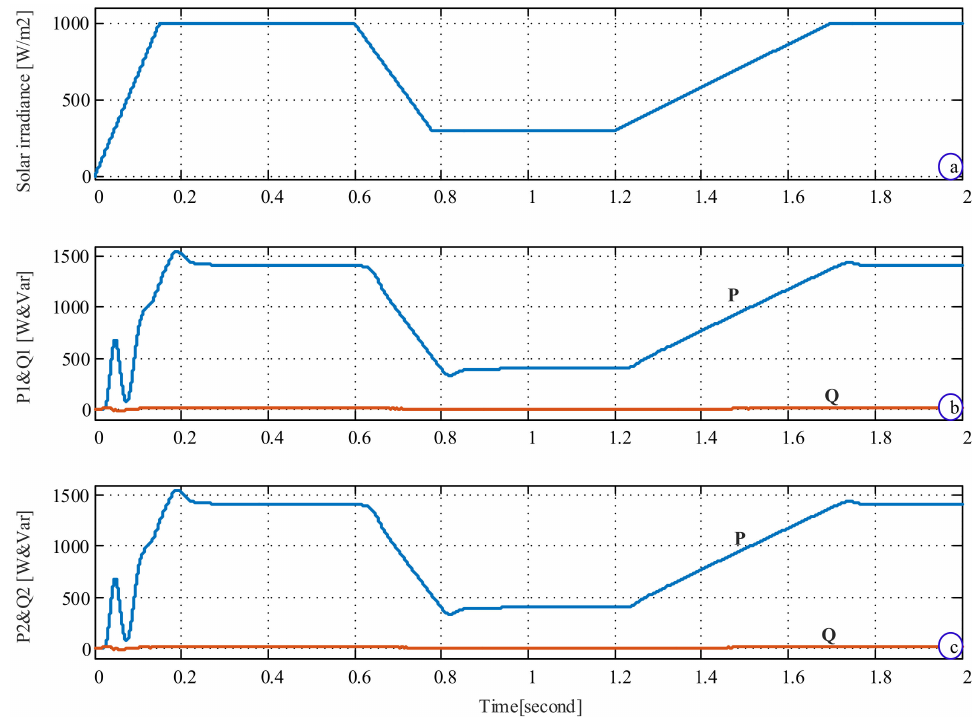
Figure 10. MPPT assessment: ( a ) solar irradiance, ( b ) ZSI1 (cid:48) s exchanged active (P) and reactive (Q) powers with the grid, ( c ) ZSI2 (cid:48) s exchanged active and reactive powers with the grid.